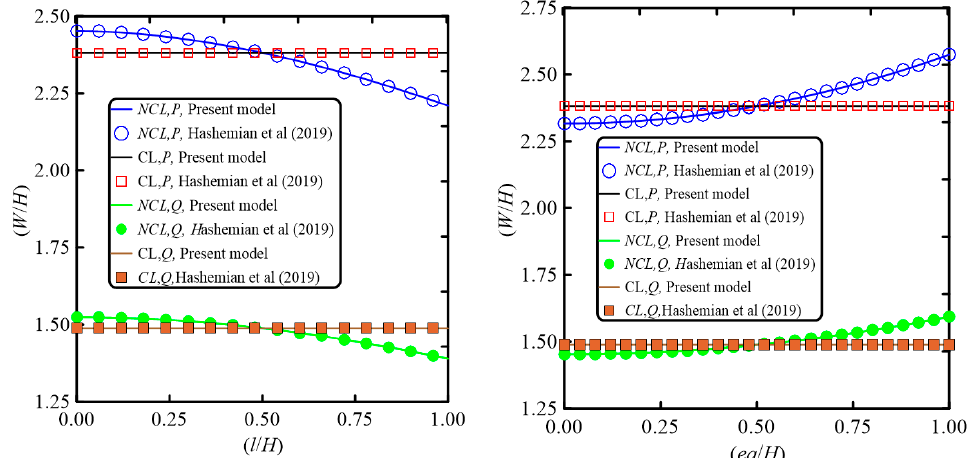
Figure 3. Comparison of the nondimensional maximum bending with the normalized nonlocal and strain gradient parameters for EBNB under uniformly distributed and central loading conditions for both classical and nonclassical analyses ( α = 1, P 0 = 50 nN, Q = 1 N/m, k w = k p = 0, ea / H = 0.5 for variable l c and l c / H = 0.5 for variable ea / H , H beam thickness).